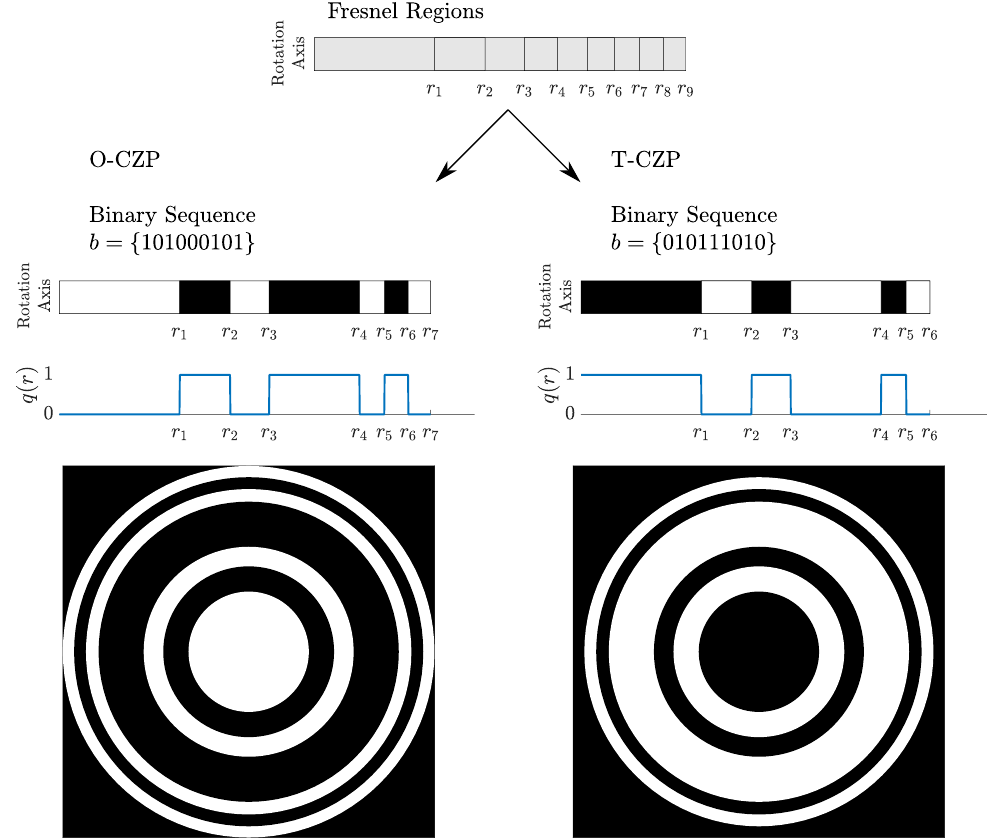
Figure 1. Cantor ZP design example using binary sequences for the opaque central region (O-CZP) and transparent central region (T-CZP) cases. From top to bottom: Fresnel region distribution for the L = 9 case, schematic view of the activation procedure of the Fresnel regions using the governing binary sequence for both O-CZP and T-CZP cases, pupil function q ( r ) , and final ZP layouts. The binary sequences used in the example correspond to the CZP case with S = 2 and L = 9 from Table